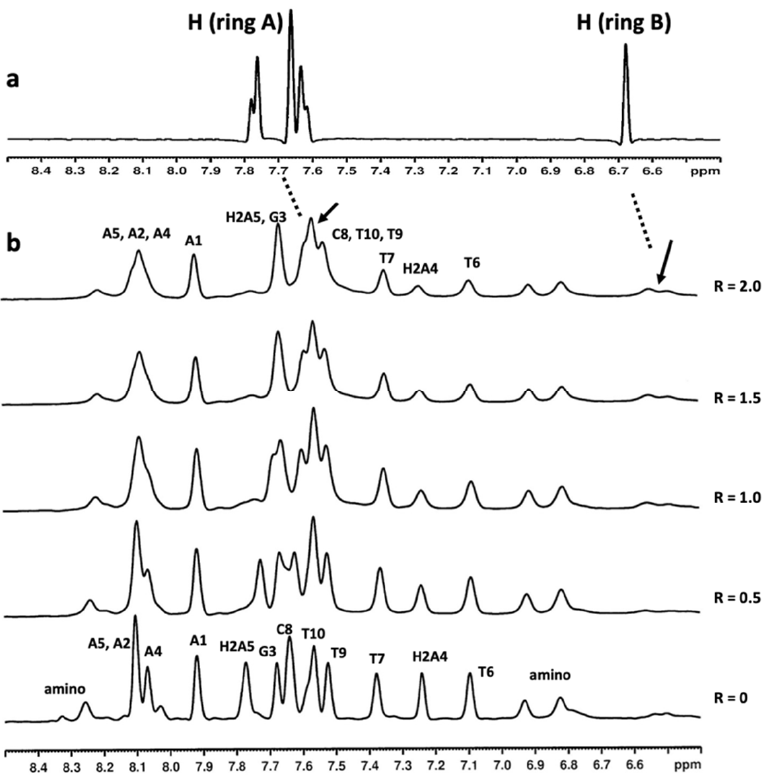
Figure 4. ( a ) Selected 1 H proton region of compound 9 at 15 °C in H 2 O/D 2 O (9:1), 100 mM NaCl and 10 mM sodium phosphate buffer (pH 7.0); ( b ) aromatic proton region of the 1 H NMR titration spectra of 5 ′ d-(AAGAATTCTT) 2 -3 ′ with compound 9 at 15 °C in H 2 O/D 2 O (9:1), 100 mM NaCl and 10 mM sodium phosphate buffer (pH 7.0), at different ratios R = [9]/[DNA]. The arrows indicate the broad proton signals of compound 9 .